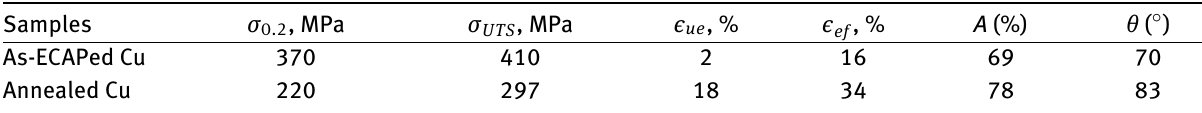
Table 1: A list of yield strength σ 0.2 , ultimate tensile strength σ UTS , uniform elongation ϵ ue , elongation to failure ϵ ef , area reduction A and shear fracture angle θ of the as-ECAPed Cu and annealed bimodal